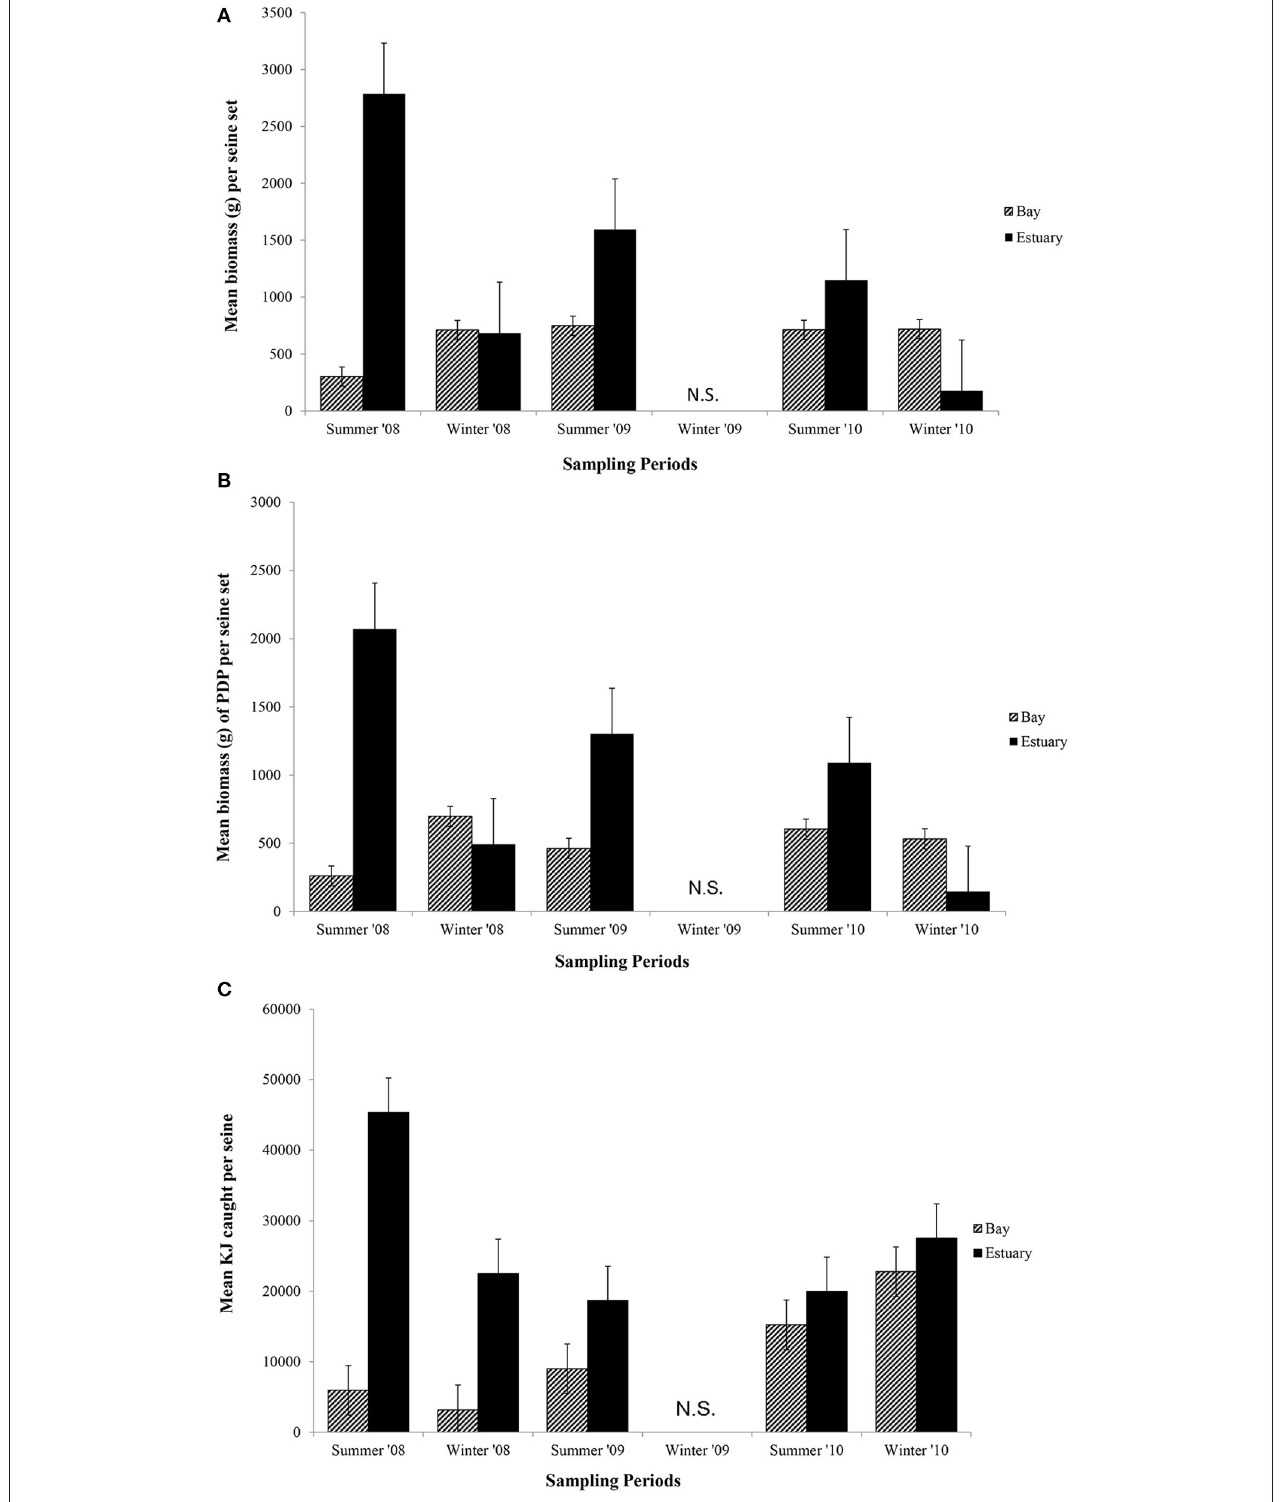
FIGURE 6 | Mean biomass ( ± 1 SE) caught per seine set for (A) total biomass; (B) biomass of PDP; and (C) KJ per seine in the Bay, and Estuary. N.S. = Not Sampled.